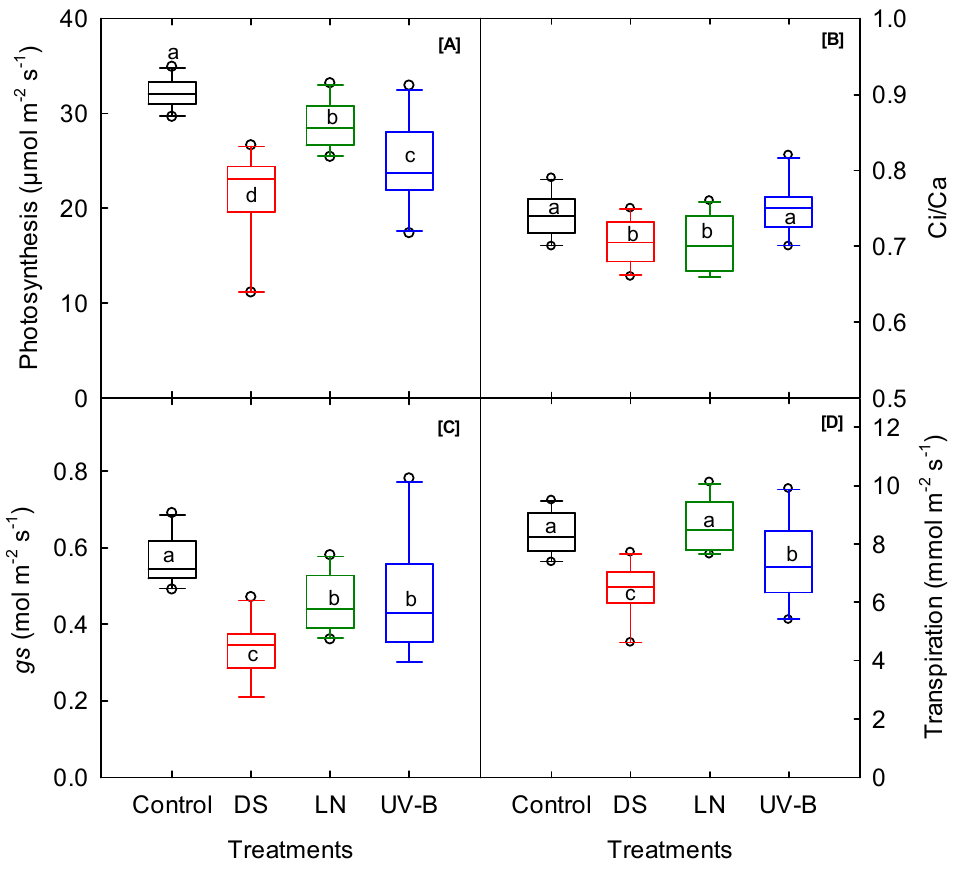
Figure 1. Drought (DS), low nitrogen (LN), and ultraviolet-B (UV-B) effect on ( A ) photosynthesis, ( B ) internal to atmospheric CO 2 concentration ratio (Ci/Ca), ( C ) stomatal conductance (gs), and ( D ) transpiration of 10 sweetpotato cultivars measured at 20 days after planting. The middle line indicates the median, and the box shows the range of the 25th to 75th percentiles of the total data. The different alphabetic letters (a, b, c, and d) labeled within the box represent the significant differences between treatments (Duncan Multiple Range Test, p < 0.05), and the outer dots are outliers.